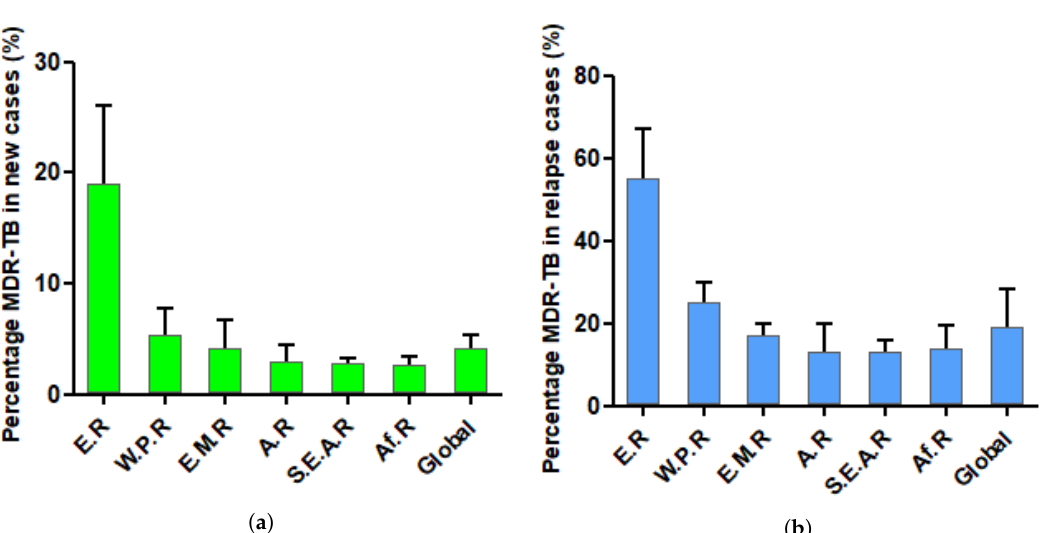
Figure 2. Percentage of MDR-TB in new tuberculosis cases ( a ) and in relapse cases ( b ) [20]. Few data are collected for Africa. E.R., European Region; W.P.R., Western Pacific Region; E.M.R., Eastern Mediterranean Region; A.R., Americas Region; S.E.A.R, Southeast Asia Region; Af.R., Africa